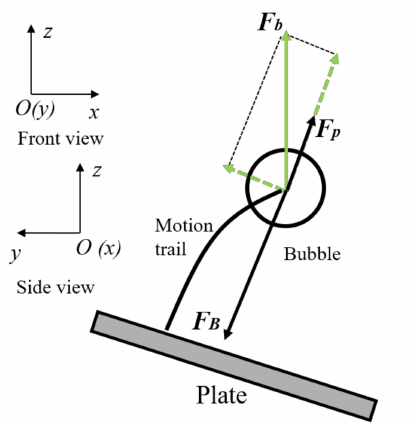
Figure 14. Mechanism analysis of bubble curve migration near bending-twisting coupled